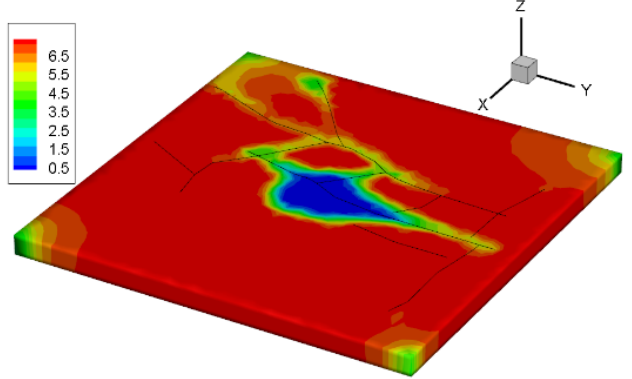
Figure 14. Adsorbed concentration of CH 4 after 30 days’ injection (unit: 1.0 × 10 − 3 m 3 /kg